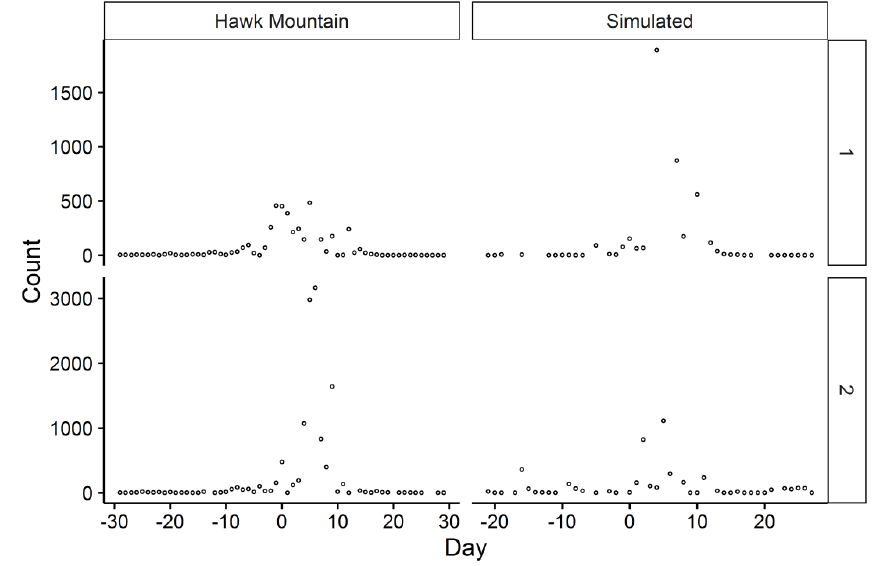
Figure A3.3. Example distribution of real and simulated daily migration counts for a species with highly overdispersed counts (Broad-winged Hawk). Real migration counts were collected at Hawk Mountain Sanctuary, Pennsylvania in 2000 (year 1, top panel) and 2001 (year 2, bottom